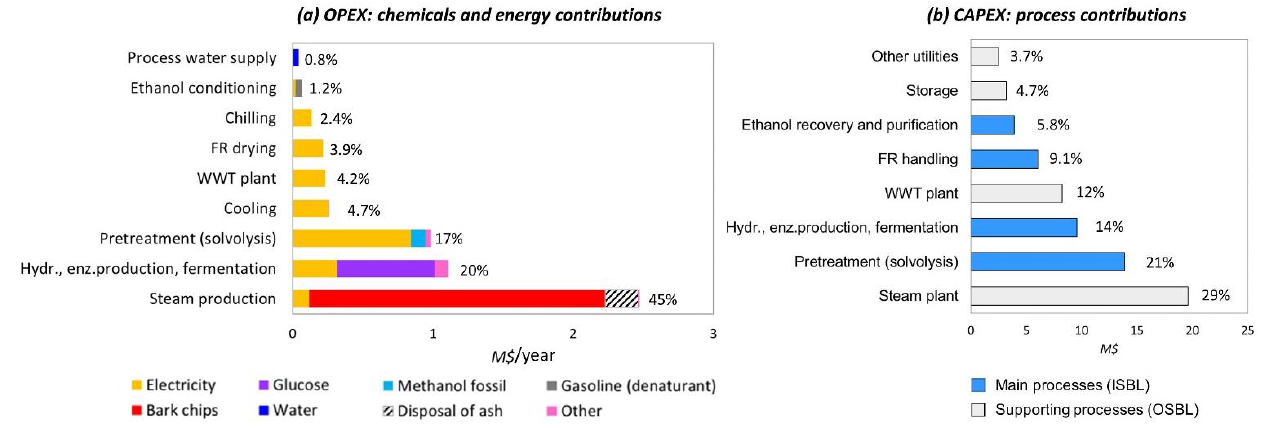
Figure 3. Chemicals and energy contribution into operational expenses and installed equipment costs (ISBL — inside battery limits; OSBL — outside battery limits).